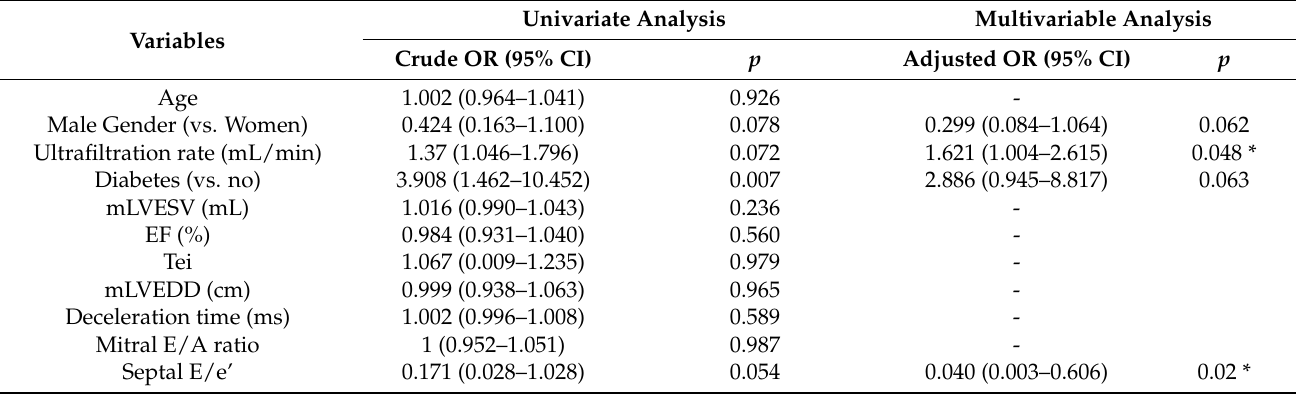
Table 6. Logistic regression analysis of factors associated with